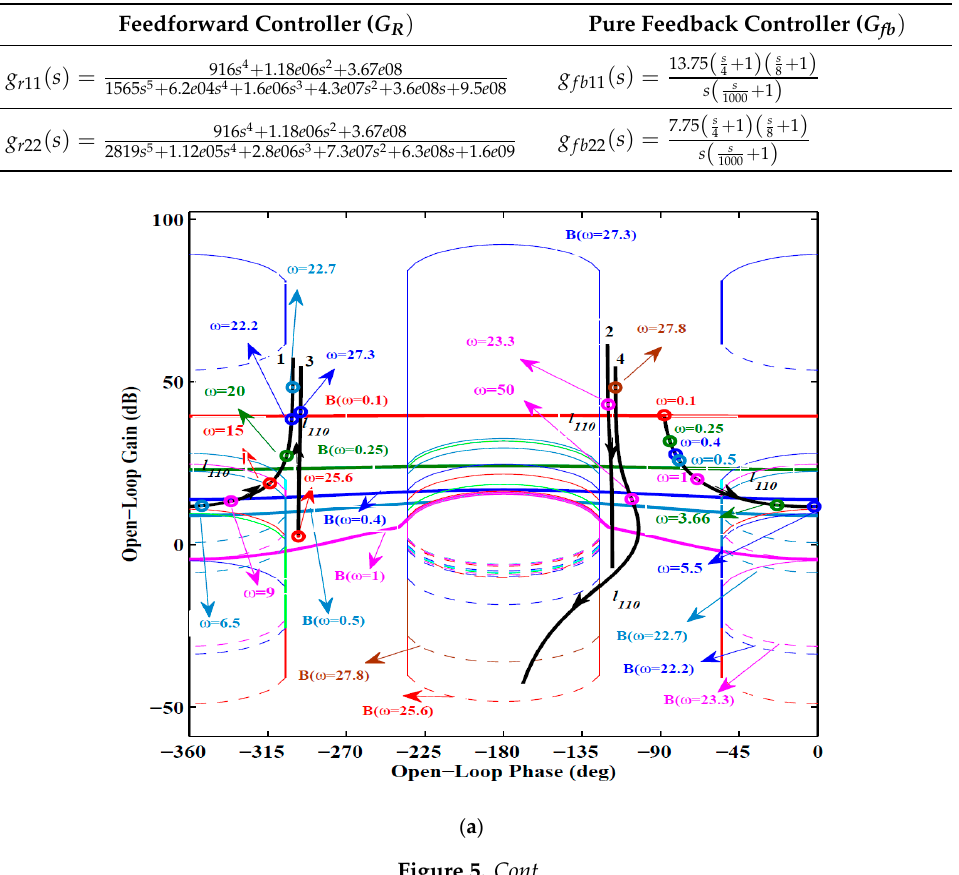
( b ) Figure 5. ( a ) The nominal loop-shaping for channel-11 (lower magnet). Here, B ( ω ) denotes the bounds at each design frequency ω and the numbers denoted in bold (1,2,3,4) at the nominal loop transmission